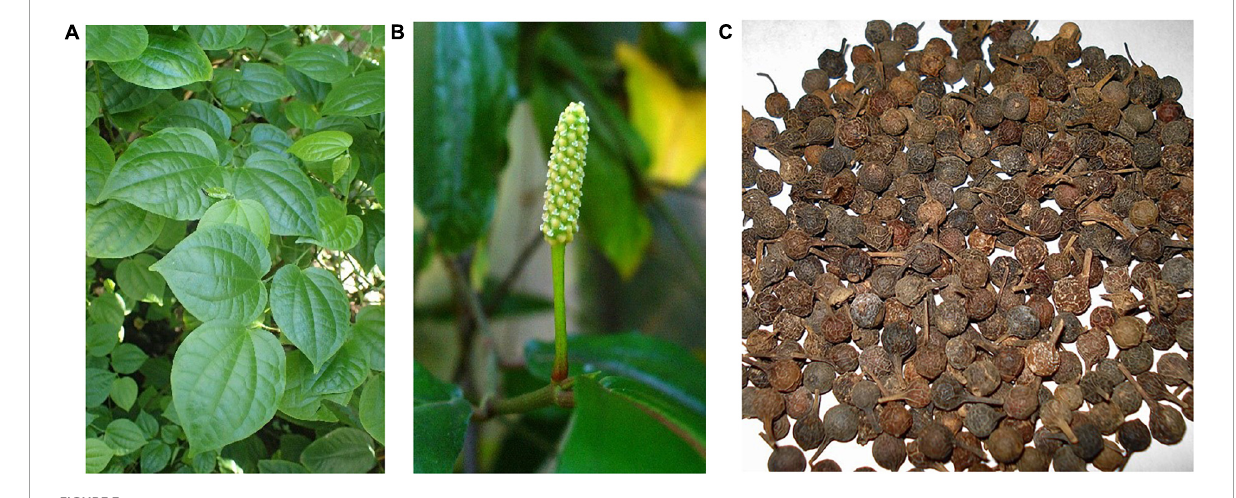
FIGURE3 Representative photos of P. cubeba (A) leaves, (B) flowers, and (C) berries.